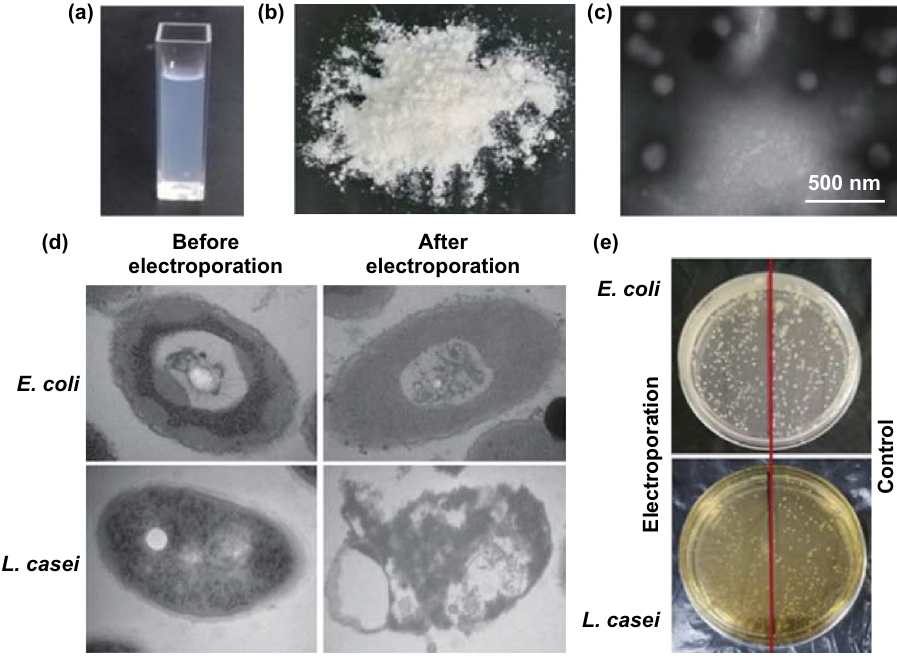
Fig. 11 Characterization of LP-in- E. coli and LP-in- L. casei . a Appearance of liposomal paclitaxel (LP). b Appearance of LP powders. c TEM image of the rehydrated of LP powders. d TEM images of E. coli and L. casei before and after electroporation. e Comparison of E. coli and L. casei colonies with and without electroporation on the petri dishes. Reprinted with permission from Ref.